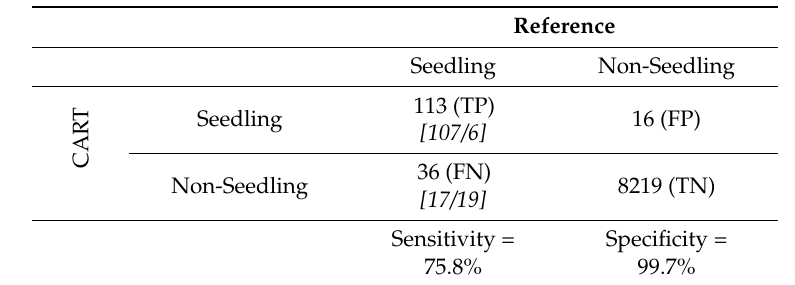
Table 3. Confusion matrix for the test data (independent validation) set. Interior matrix cells indicate both correctly classified objects (true positives [TP] and true negatives [TN]) and errors (false positives [FP] and false negatives [FN]). Square brackets in the interior cells break down the seedling reference data by species [pine/spruce].